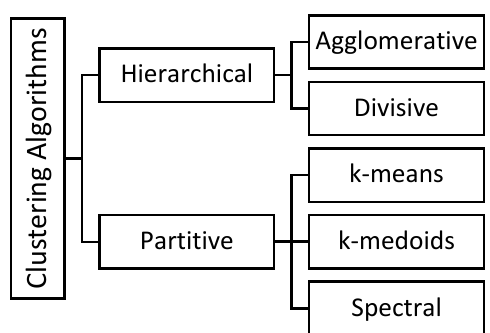
Figure 11. Main clustering techniques.